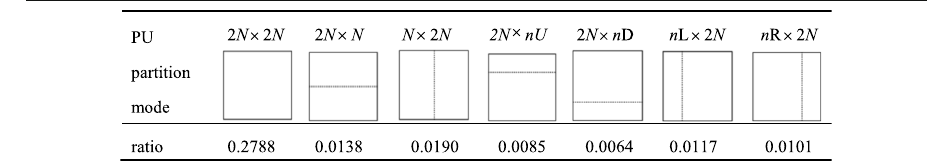
Table 6 PU partition mode distribution for 16× 16-sized